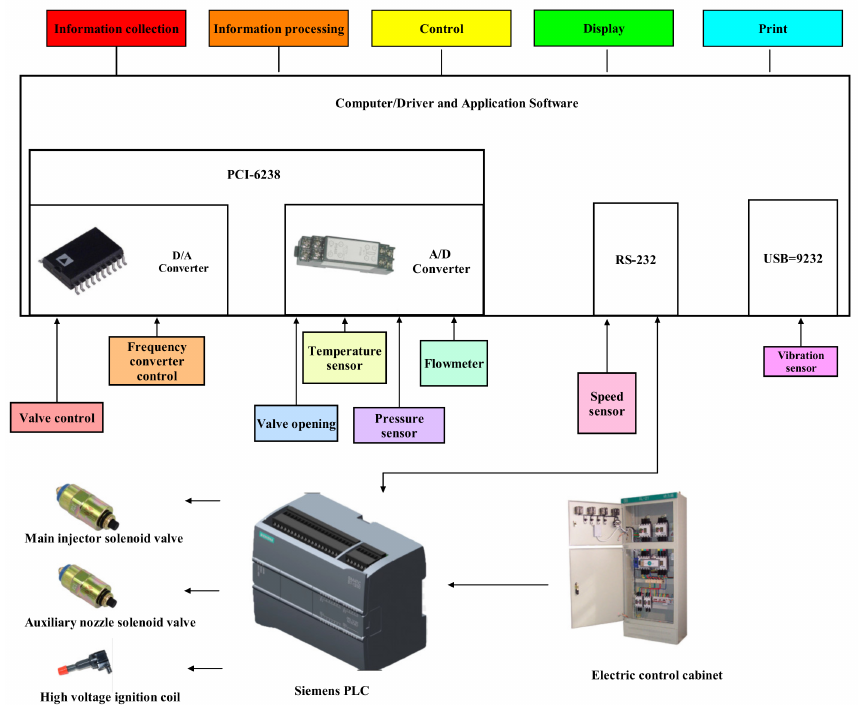
Figure 3. Structure diagram of measurement and control system for turbocharger test